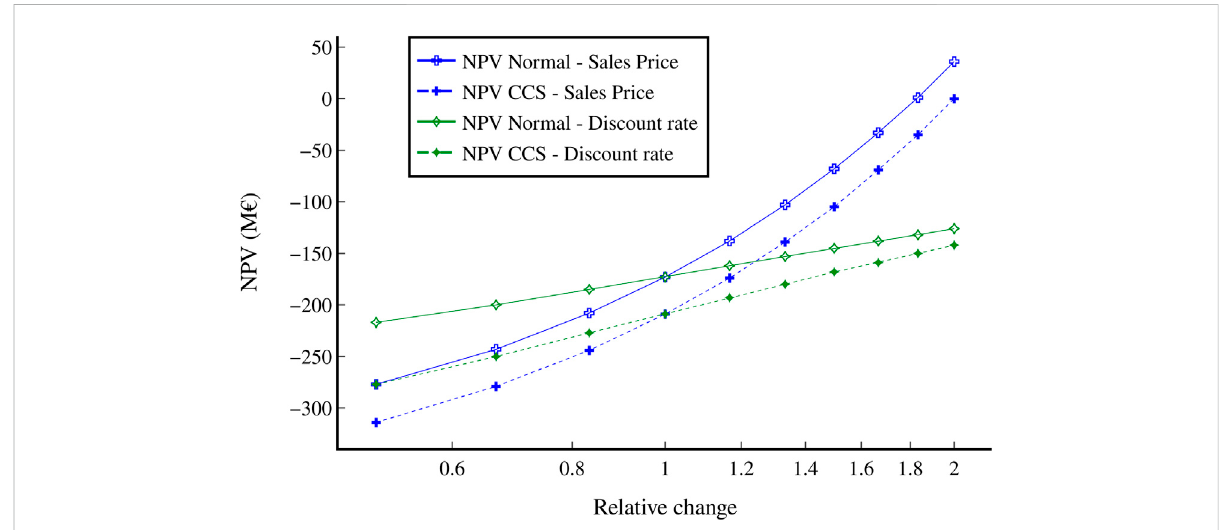
FIGURE 14 Change in NPV for both scenarios with respect to changes in the sales price and discount rate. All other variables remained constant.